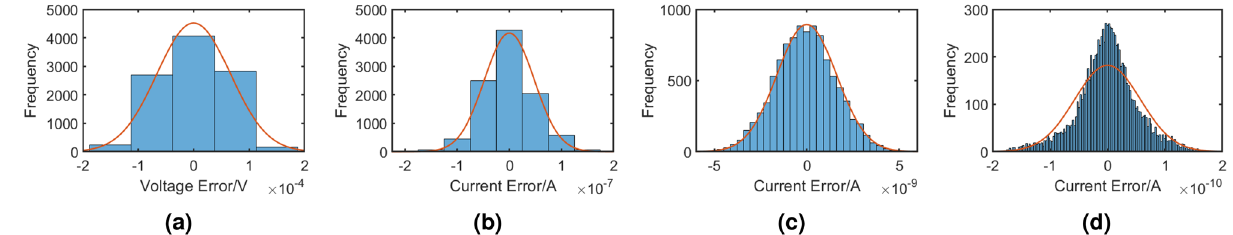
Figure 5. Histograms showing noise characteristics of the various modes of measurement. All histograms have one bin per ADC code with widths of 78.1 µ V , 47.6 nA , 355 pA , and 2.60 pA respectively. ( a ) 10k point histogram of a read-out voltage error test (V=GND), overlaid with Gaussian distribution estimate. We obtain σ = 66 µ V . ( b – d ) 10k point histograms of current read-out tests, overlaid with Gaussian distribution estimates. ( b ) 820 (cid:31) TIA range yields σ = 48nA . ( c ) the 110 k (cid:31) TIA range yields σ = 1.6nA . ( d ) the 15M (cid:31) TIA range yields σ = 57 pA .